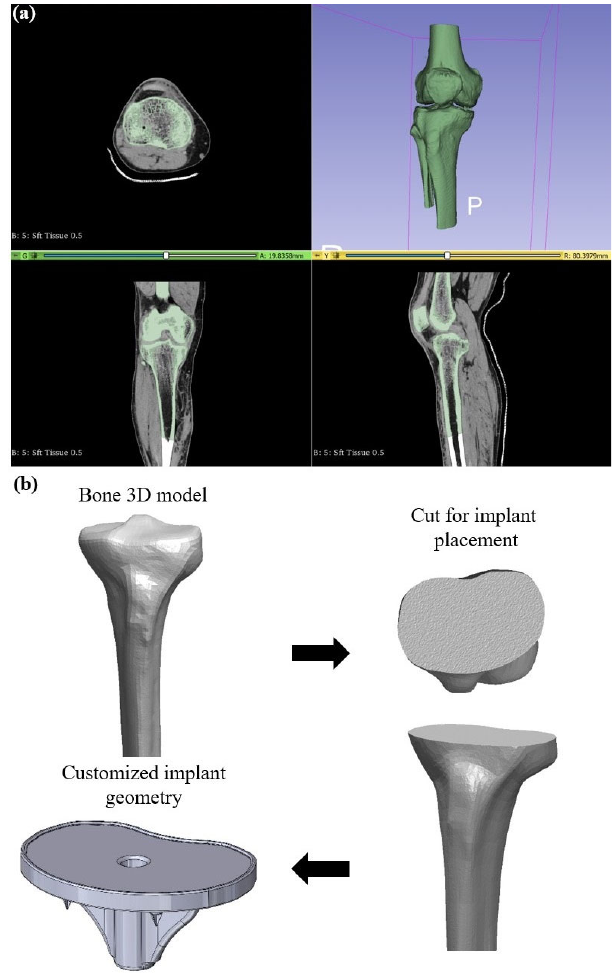
Figure 3. ( a ) Indicative images from the reconstruction process in 3DSlicer; ( b ) Workflow of the exportation of customized implant’s geometry.